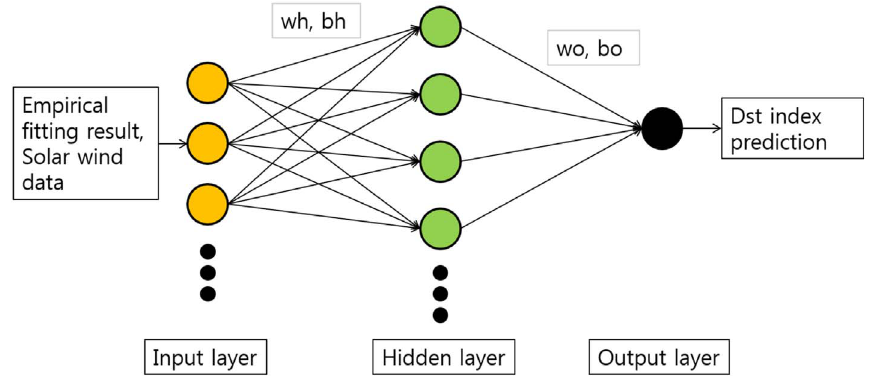
Fig. 1. Arti fi cial neural network architecture consisting of input, hidden, and output layers. Table 1. Simple arti fi cial neural network input parameters. Parameter